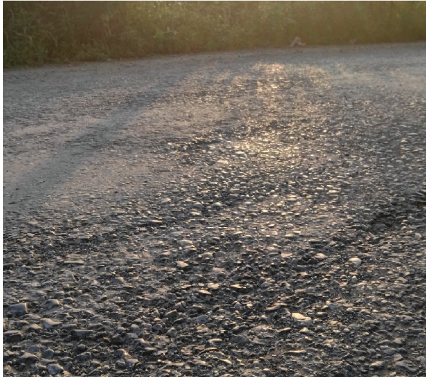
Figure 24: Typical ravelling in test section in May